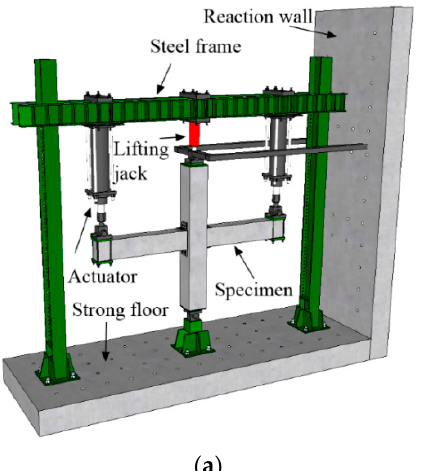
Figure 6. Illustration and photographs of the experimental setup: ( a ) illustration of the experimental setup; ( b ) photographs of the experimental setup.